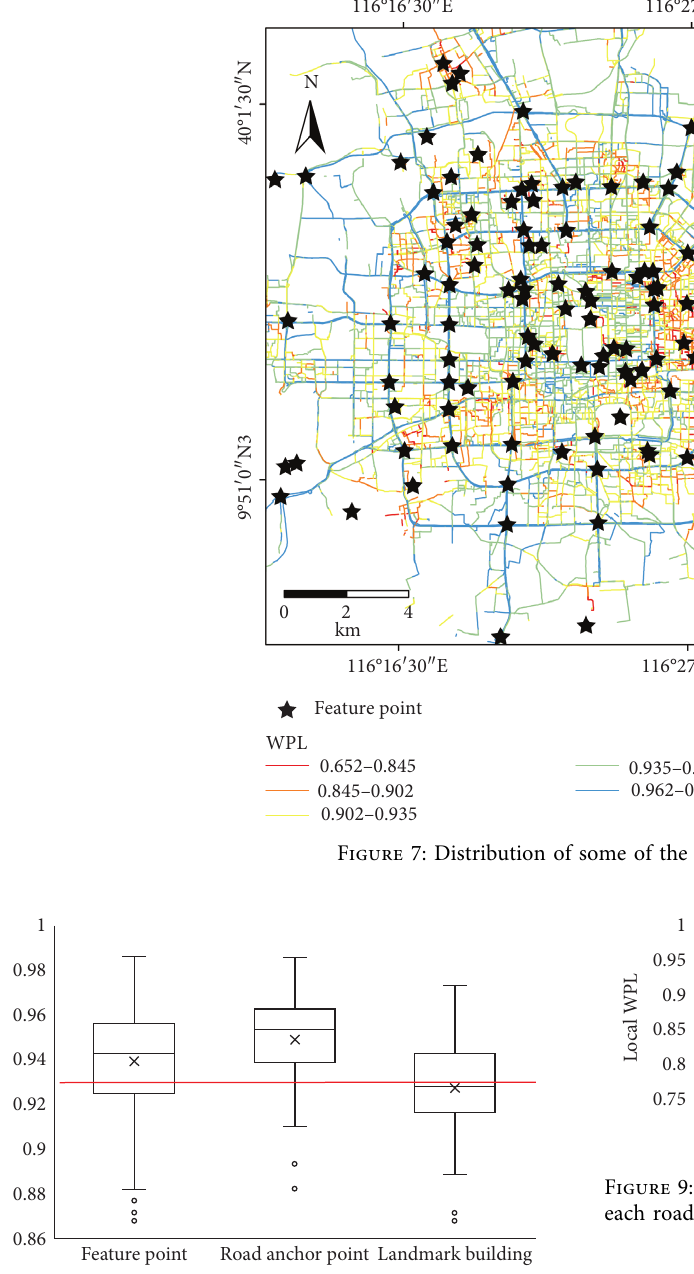
Figure 8: Statistics of the local wayfinding performance levels around the feature points.